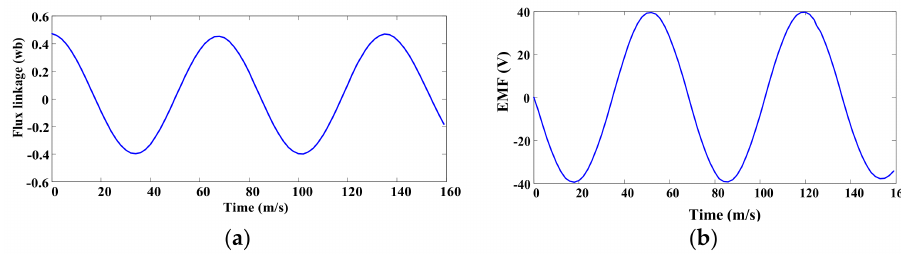
Figure 8. TPMLG waveforms at constant velocity: ( a ) flux linkage and ( b ) EMF